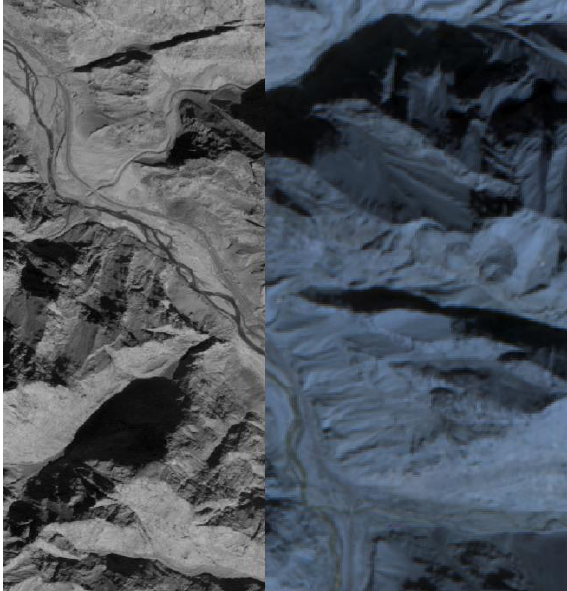
Figure 6. Full-color image and multispectral image overlay （ 4 ）